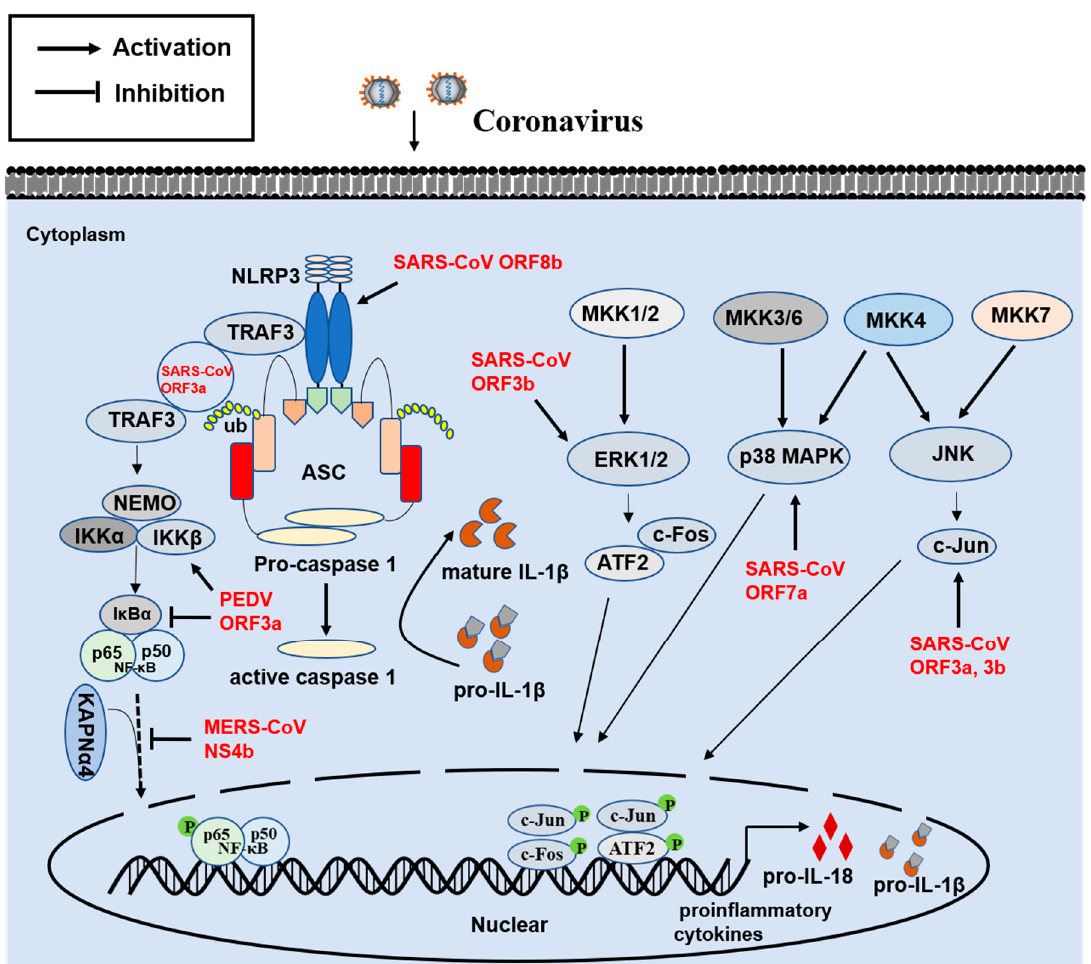
Figure 3. Modulation of an innate immune proinflammation response by coronavirus accessory proteins. Schematic diagram showing the activation and modulation of NLRP3 inflammasome and the MAPK signaling pathway by accessory proteins. Accessory proteins modulating the pathway are shown in red. Abbreviations: NLRP3, NLR family pyrin domain containing 3; TRAF3, TNF receptor-associated factor 3; ASC, apoptosis-associated speck-like protein containing a caspase recruitment domain; NEMO, NF- κ B essential modulator; IKK α , inhibitor of κ B kinase α ; IKK β , inhibitor of κ B kinase β ; KAPN- α 4, karyopherin- α 4; MAPK, mitogen activated protein kinases; MKK, MAP kinase kinases; ERK1/2, extracellular signal-regulated kinase 1/2; JNK, c-Jun N-terminal kinases; c-Fos, cellular FBJ murine osteosarcoma; ATF2, activating transcription factor 2; P, phosphate.